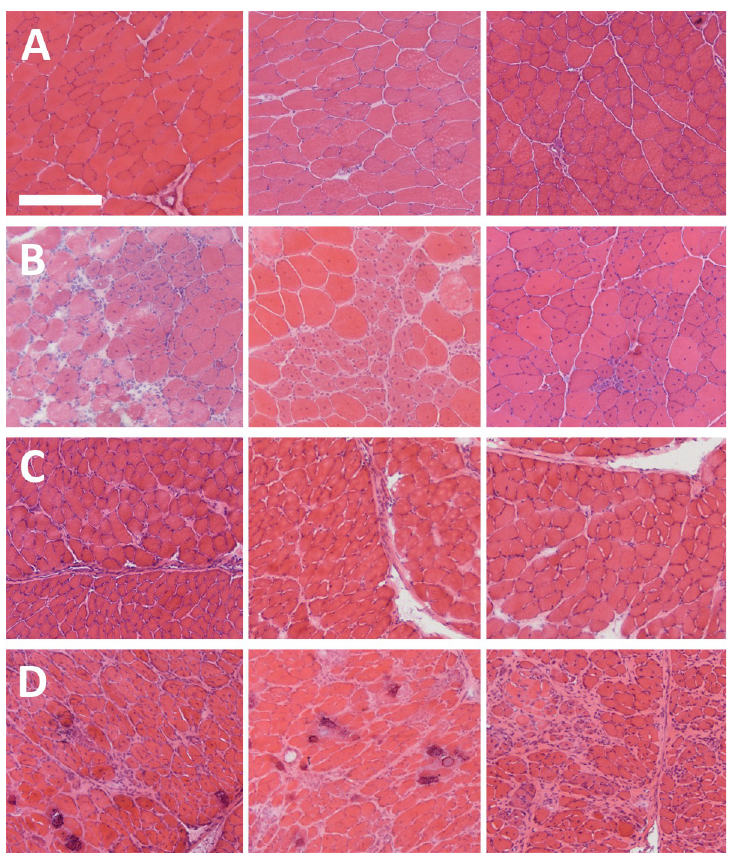
Fig 1. Disease progression in the mdx mouse. Representative Haematoxylin and Eosin stains of tissues used in this study. Top row ( A ): WT Tibialis anterior (TA) muscle; Second row ( B ): mdx TA muscle; Third row ( C ): WT diaphragm muscle; Bottom row ( D ): mdx diaphragm muscle. Left column: 6 week samples; Centre column: 10 week samples, Right column: 24 week samples. Note the prominent necrosis and oedema characteristic of the 6-week acute phase, the steady accumulation of centrally-nucleated fibres with age and the marked fibrosis and calcium deposition in dystrophic diaphragms. Scale bar: 200um.